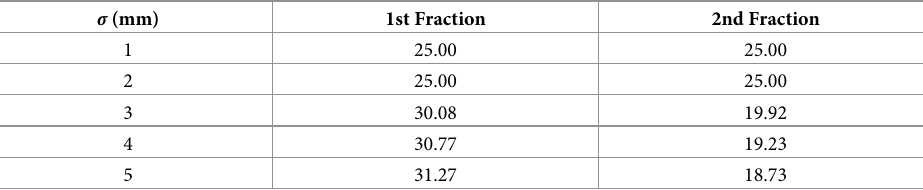
Table 6. Variation of flux over two fractions.